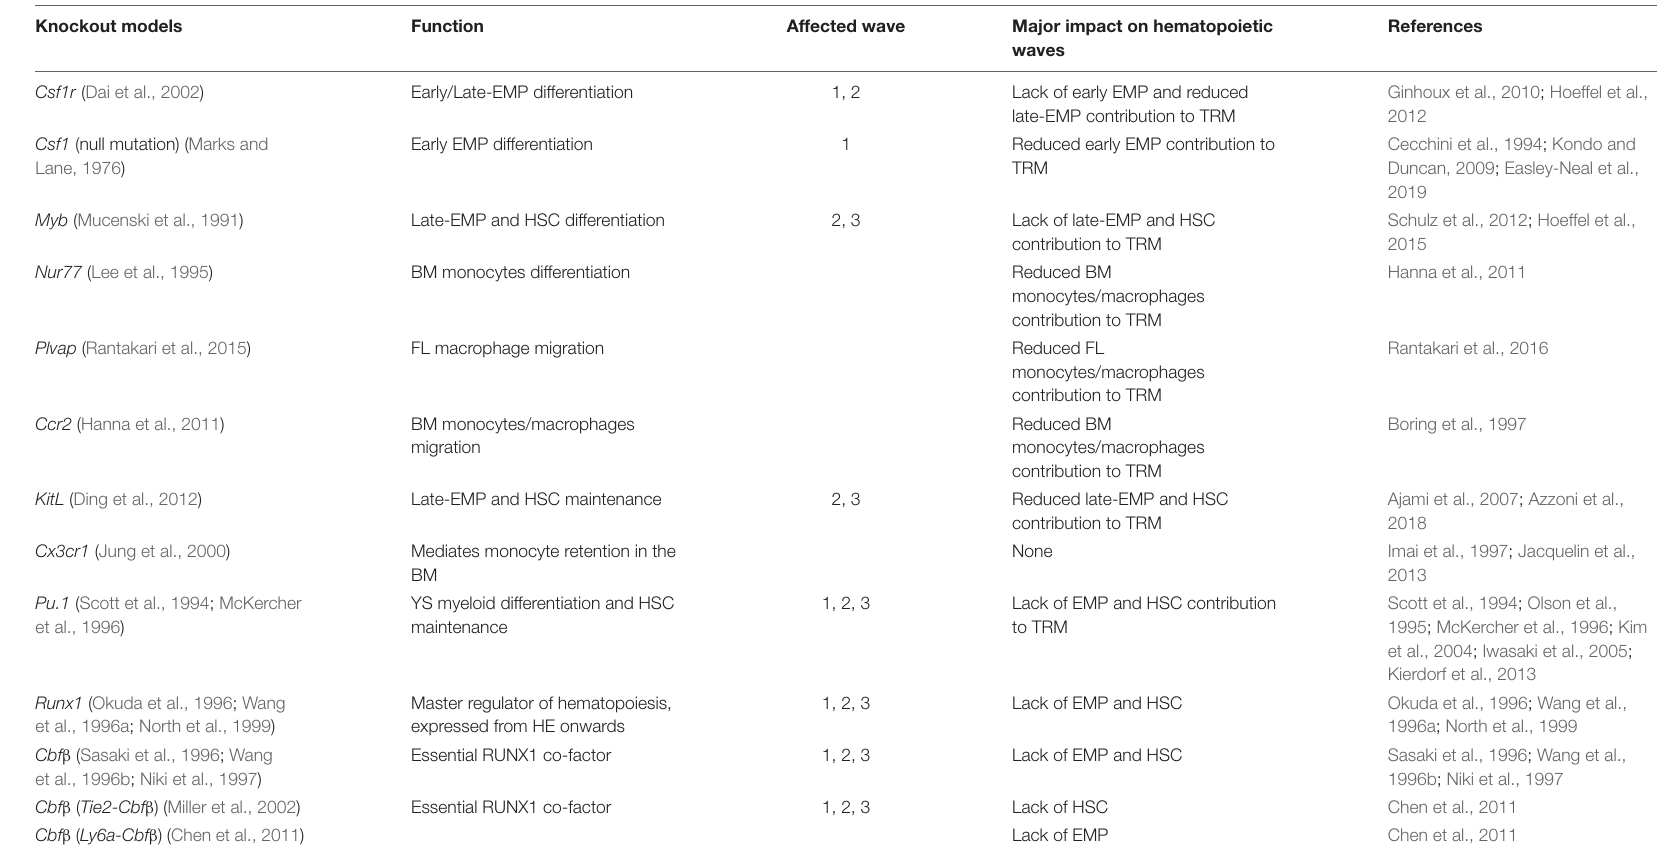
TABLE 1 | Mouse model for studying the contribution of different hematopoietic waves to hematopoietic